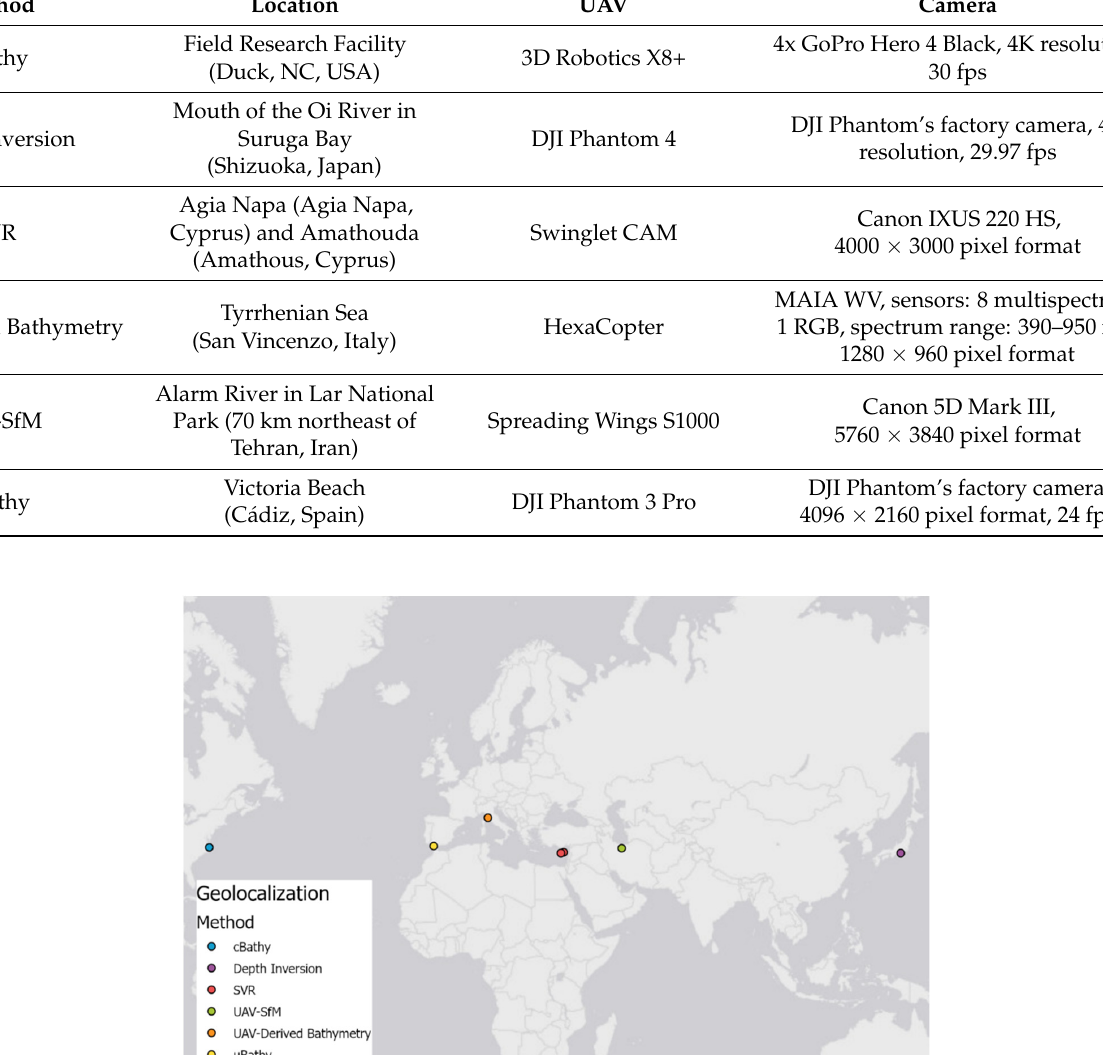
Table 2. Measurement locations and equipment according to the method used to determine the waterbody depth.